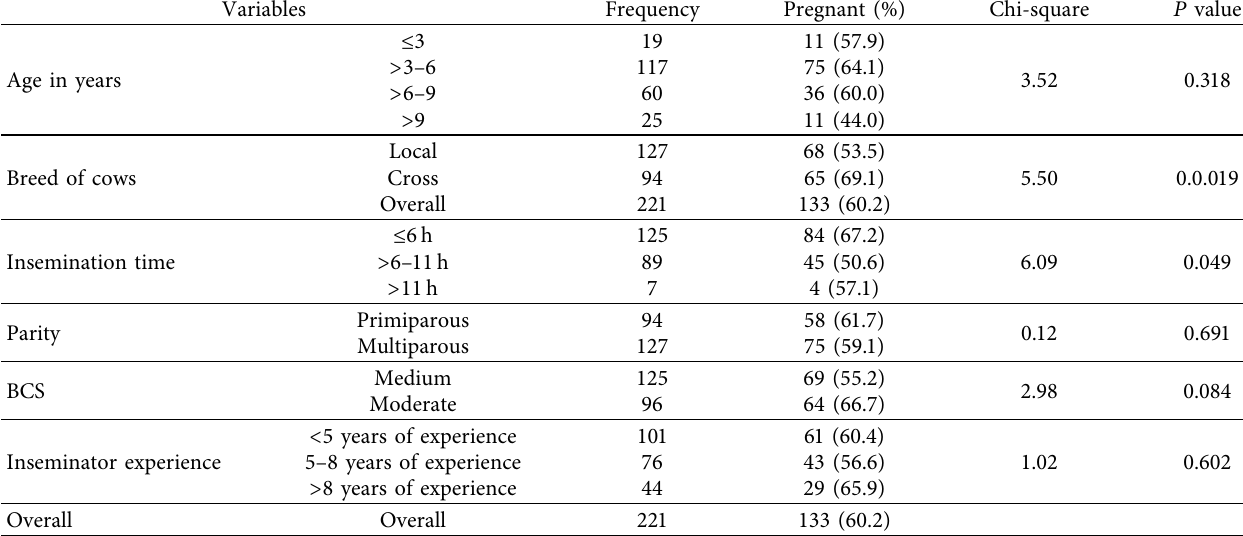
Table 1: Efficiency of AI related to different factors.